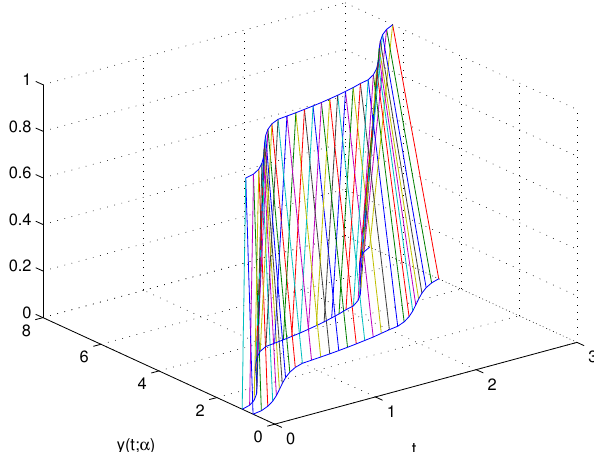
Figure 6. Approximate solution obtained with the RK-4 method for h = 0.14, α ∈ [ 0,1 ] and t ∈ [ 0,3 ]